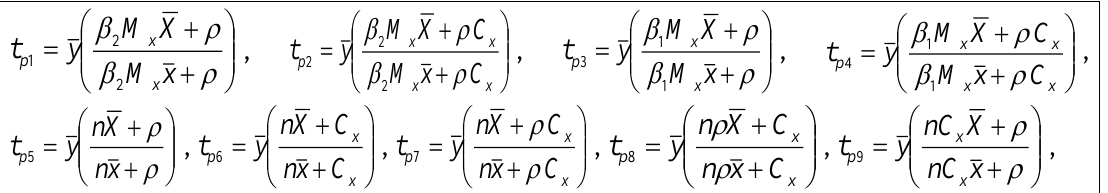
Table 2. Various members of the proposed